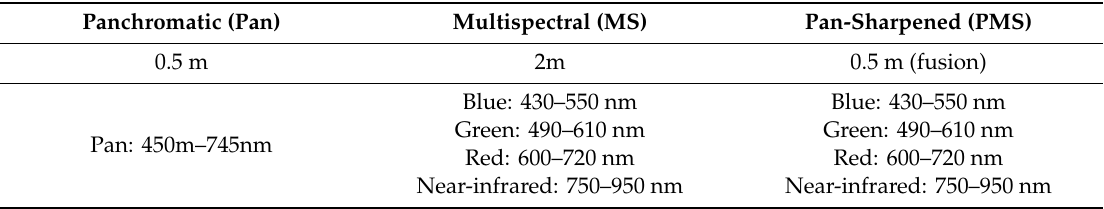
Table 1. Very high-resolution Pleiades spectral combinations.